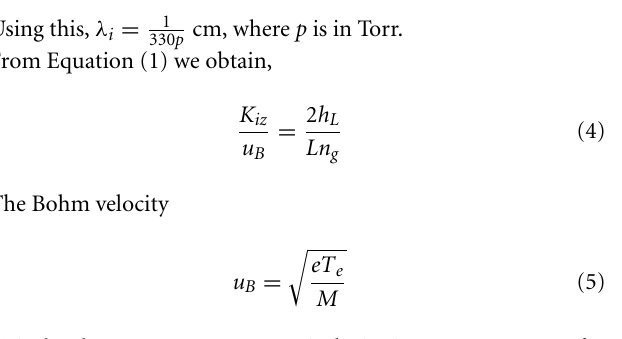
Using this, λ i = 1